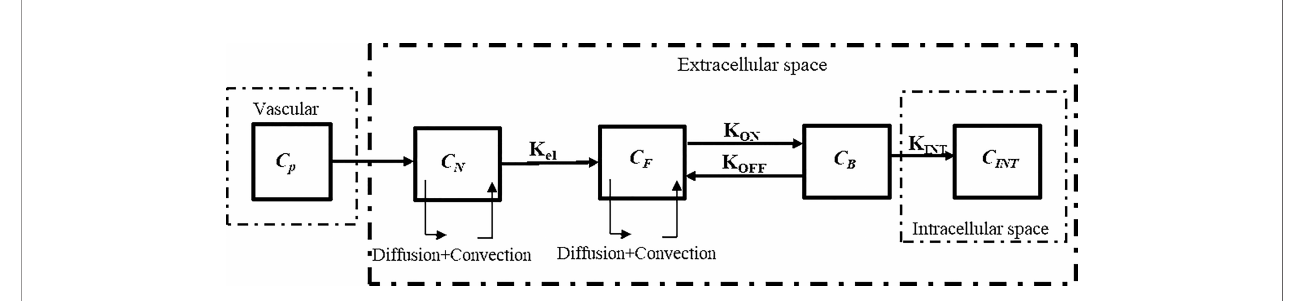
FIGURE 2 | Block diagram of the current study for computational modeling of drug transport of